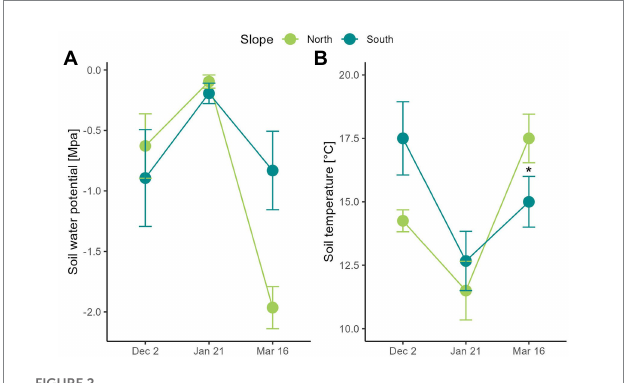
FIGURE 2 Soil climatic conditions measured in two contrasting slopes in the Nevados de Chillán Volcano complex. (A) Water potential (MPa) and (B) soil temperature ( ° C) was measured at 15 cm of soil depth on two contrasting slopes. Values correspond to average ± SE ( n = 3). Dashed grey lines indicate temperature thresholds for plant physiology: heat (30 ° C) – freezing (0 ° C). Blue arrows indicate snowfall. Asterisks show significant differences (Repeated measures ANOVA, p <